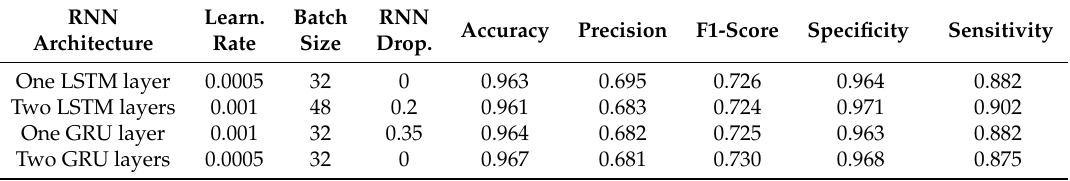
Table 4. Best results obtained after grid search optimization.